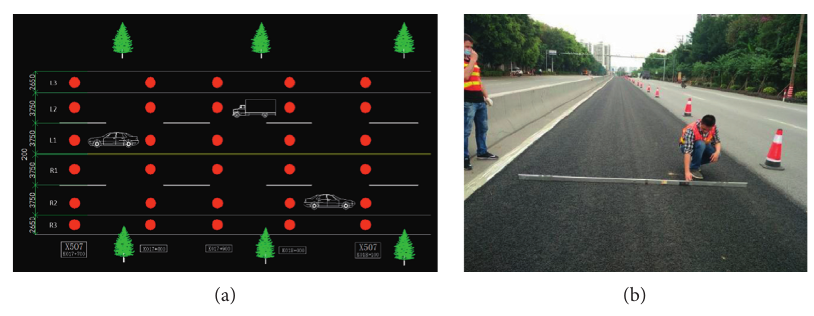
Figure 7: Pavement surface regularity test. (a) Selected testing spots. (b) 3m straightedge.